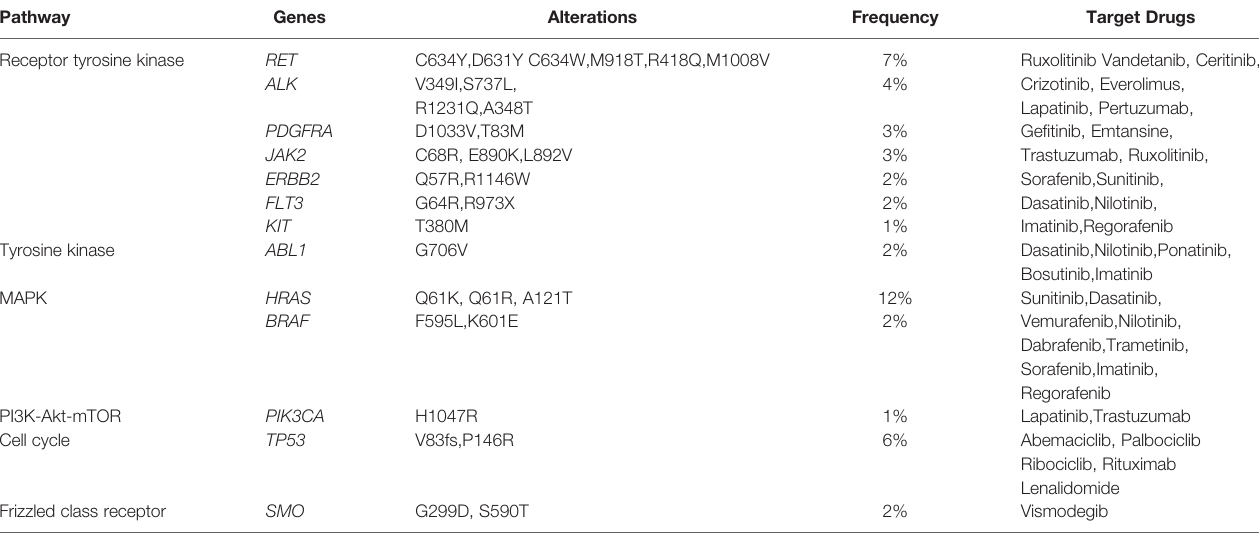
TABLE 6 | Actionable genomic variants in 107 PPGL. Pathway